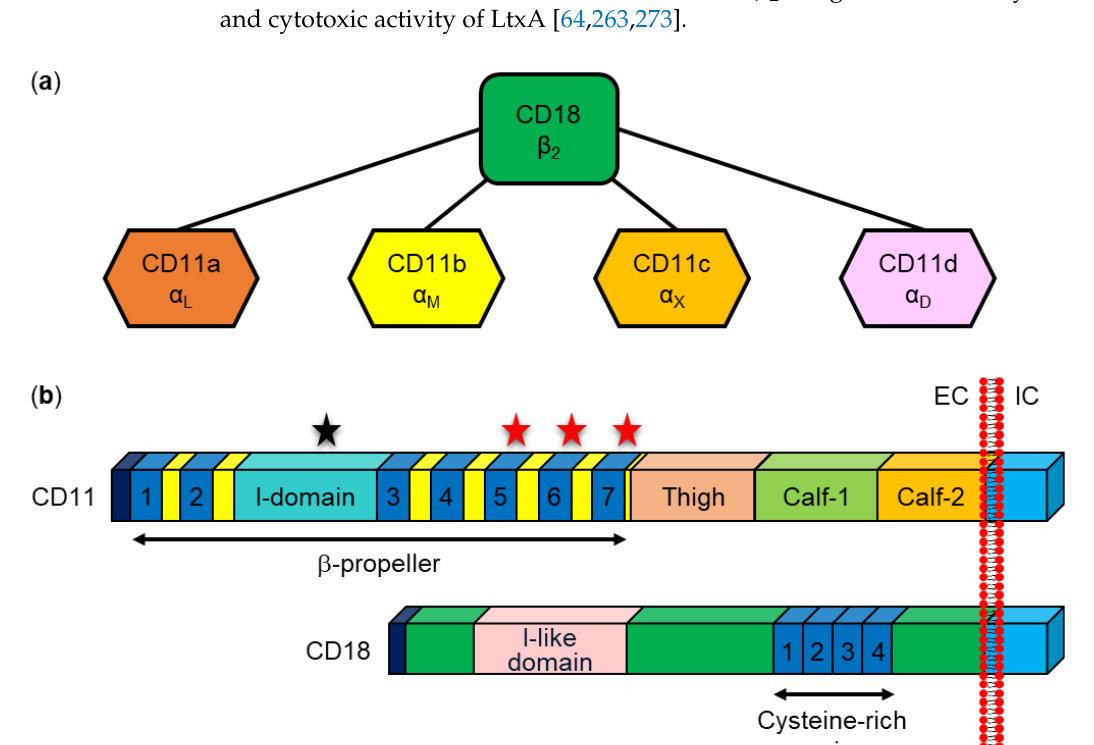
Figure 7. Schematic representation of the β 2 integrins. ( a ) The common CD18 ( β 2 ) subunit (green) non-covalently associates with one of the four α -subunits, including CD11a ( α L ; orange), CD11b ( α M ; yellow), CD11c ( α X ; gold), and CD11d ( α D ; lavender). ( b ) The CD11 and CD18 subunits of β 2 integrins consist of a long N-terminal extracellular domain, a single transmembrane α -helical segment, and a short C-terminal cytoplasmic segment. The extracellular domain of the CD11 subunits consists of an N-terminal secretion signal (navy blue), 7 β -sheet repeats (1 to 7; dark blue) that fold into a β -propeller domain, an I-domain (water blue) inserted between repeats 2 and 3 of the β -propeller domain, a thigh domain (sienna), and 2 calf domains (calf-1 in green and calf-2 in gold). The I-domain contains an Mg 2+ -binding site (black star) and repeats 5, 6, and 7 have Ca 2+ -binding EF-hand motifs (red stars). The extracellular domain of the CD18 subunit contains an N-terminal secretion signal (navy blue), an I-like domain (light pink), and a cysteine-rich region with four I-EGF-like domains (1 to 4; dark blue). Extracellular (EC) and intracellular (IC) compartments are separated by the cell membrane (red dots with short black lines).